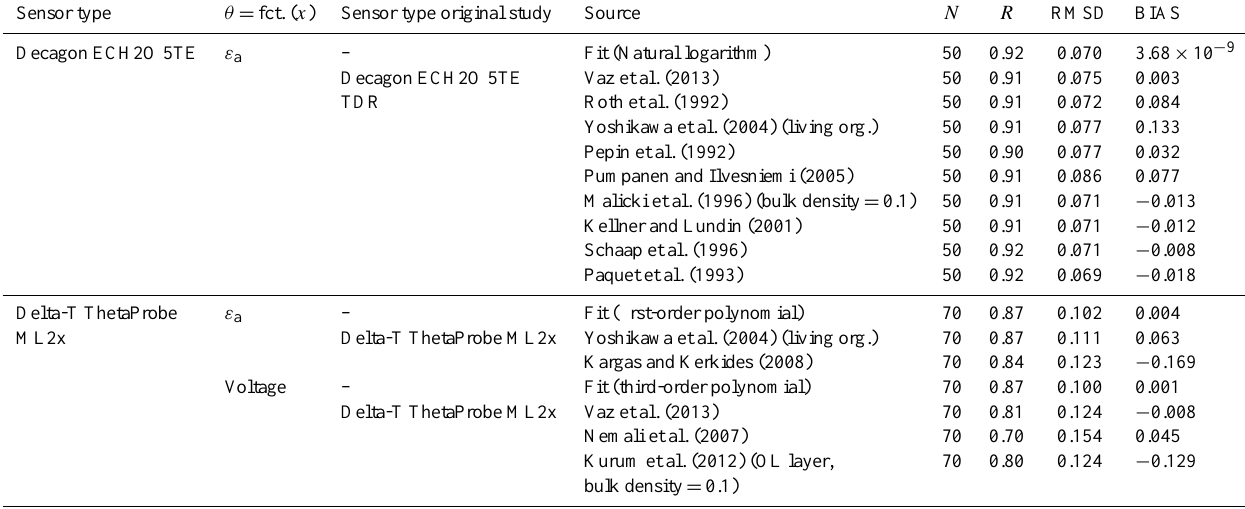
Table 6. Statistics for the applied petrophysical and empirical relationships for organic soil layers extracted from the literature as well as for manufacturer’s default calibration curves and our best fits (as presented in Fig. 4). N is the number of sampling points, R is Pearson’s correlation coefficient, RMSD is bias-corrected root mean square deviation, BIAS is bias, θ is volumetric moisture content, ε a is apparent relative permittivity.